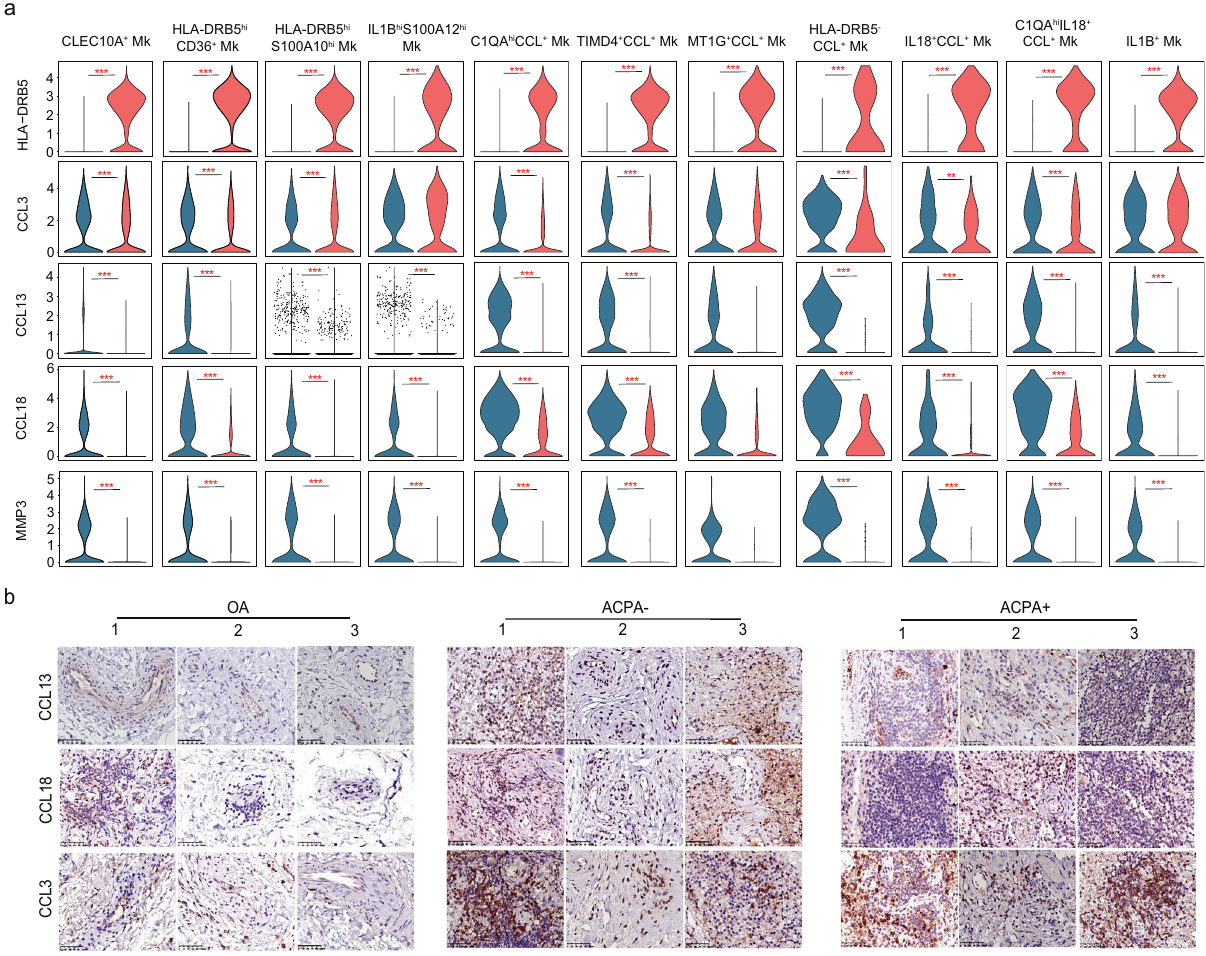
Fig. 6 CCL + macrophages are enriched in the synovial tissue of patients with ACPA- RA. a Violin plots showing the differences in the expression of HLA- DRB5, CCL3, CCL13, CCL18, and MMP3 between ACPA- and ACPA + macrophage subtypes in STMC. Asterisks indicate the signi fi cance. P values were calculated by the two-sided Wilcoxon test. * p < 0.05, ** p < 0.01, *** p < 0.001. b Immunohistochemistry of CCL3, CCL13, and CCL18 expression in the synovial tissue of 3 OA, 3 ACPA- RA, and 3 ACPA + RA patients. The immunohistochemistry results were carried out in one independent experiment of three biological replicates from each